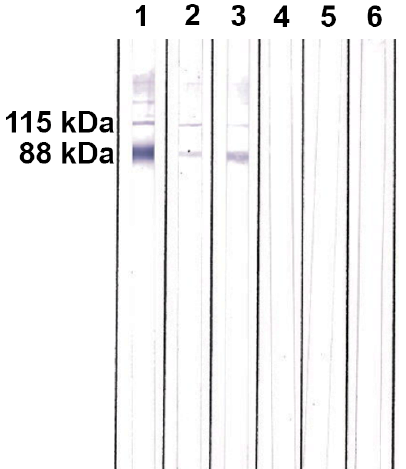
Figure 4. Western blot assay for anti- Histoplasma antibody detection: Line 1 = positive control (patient with proven histoplasmosis), line 2 = case 1, line 3 = case 2, line 4 = negative control (patient with COVID-19), line 5 = negative control (normal human serum), line 6 = secondary antibody control. Molecular weights of H and M antigens of H. capsulatum are indicated at the left.